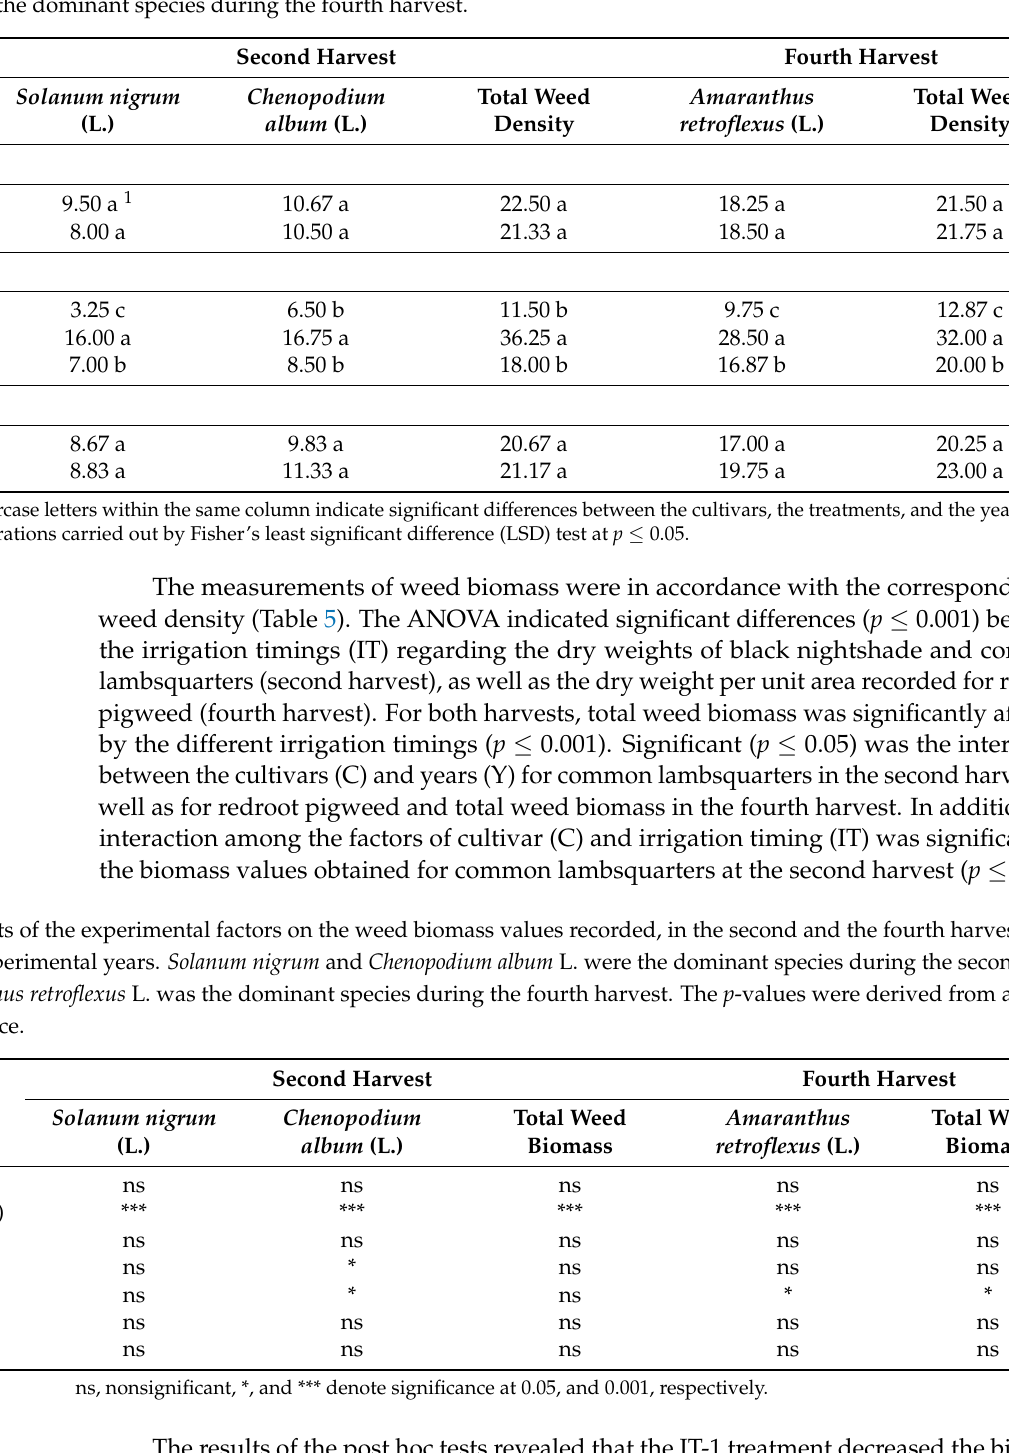
Table 4. The weed density (plants · m − 2 ) values recorded, in the second and the fourth harvest, across the two experimental years. Solanum nigrum and Chenopodium album L. were the dominant species during the second harvest. Amaranthus retroflexus L. was the dominant species during the fourth harvest.